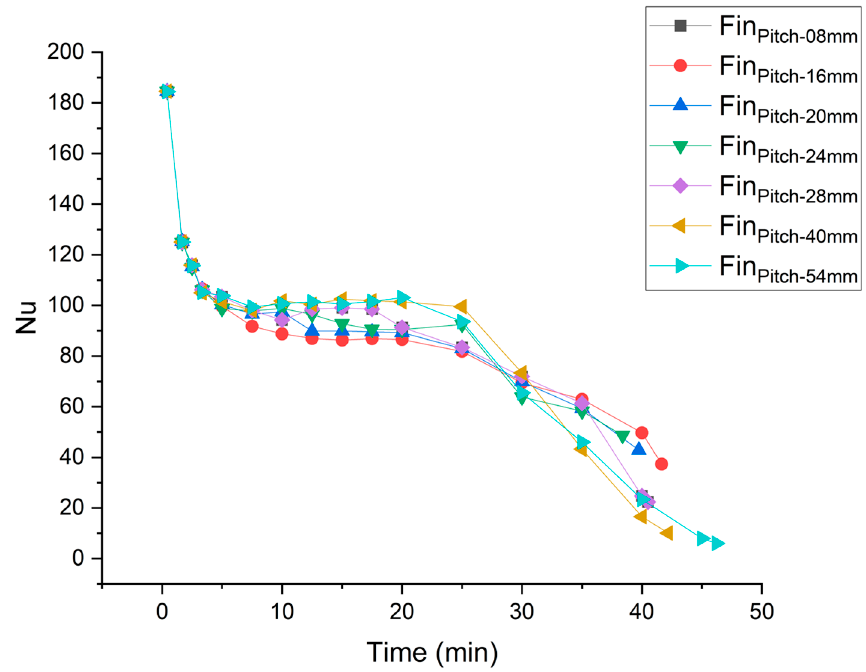
Figure 10. Nusselt number variation with time at different pitches. The asymmetric fin’s placement optimizes the initial higher Nusselt number, average Nusselt number in convection dominance regime, and prolongation of the convection dominance regime. Nusselt numbers for asymmetric (optimized) and symmetric fin place- ments are compared in Figure 12. Asymmetrically placed fins show prolongation of the convection dominance regime. Convection weakens very late in the melting process. In